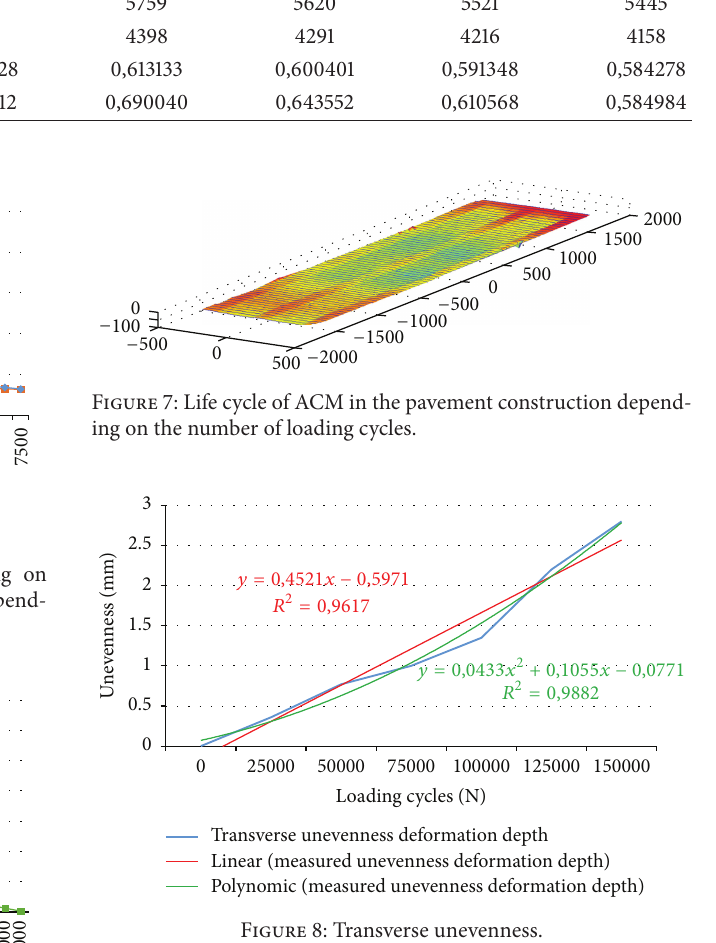
Figure 7. Trend line of deformation in relation to load was derived and it is shown in Figure